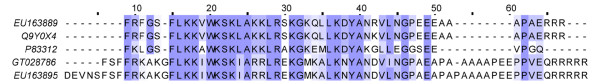
Sequence alignment of bpp like. GT02s represent the dbEST accession numbers for Yunnan-sourced Lychas mucronatus cDNA library. EU15s represent the GenBank accession numbers for Hainan-sourced Lychas mucronatus cDNA library. Q9Y0X4 represents Bradykinin-potentiating peptide BmK3 from Mesobuthus martensii, P83312 represents Parabutoporin from Parabuthus schlechteri.